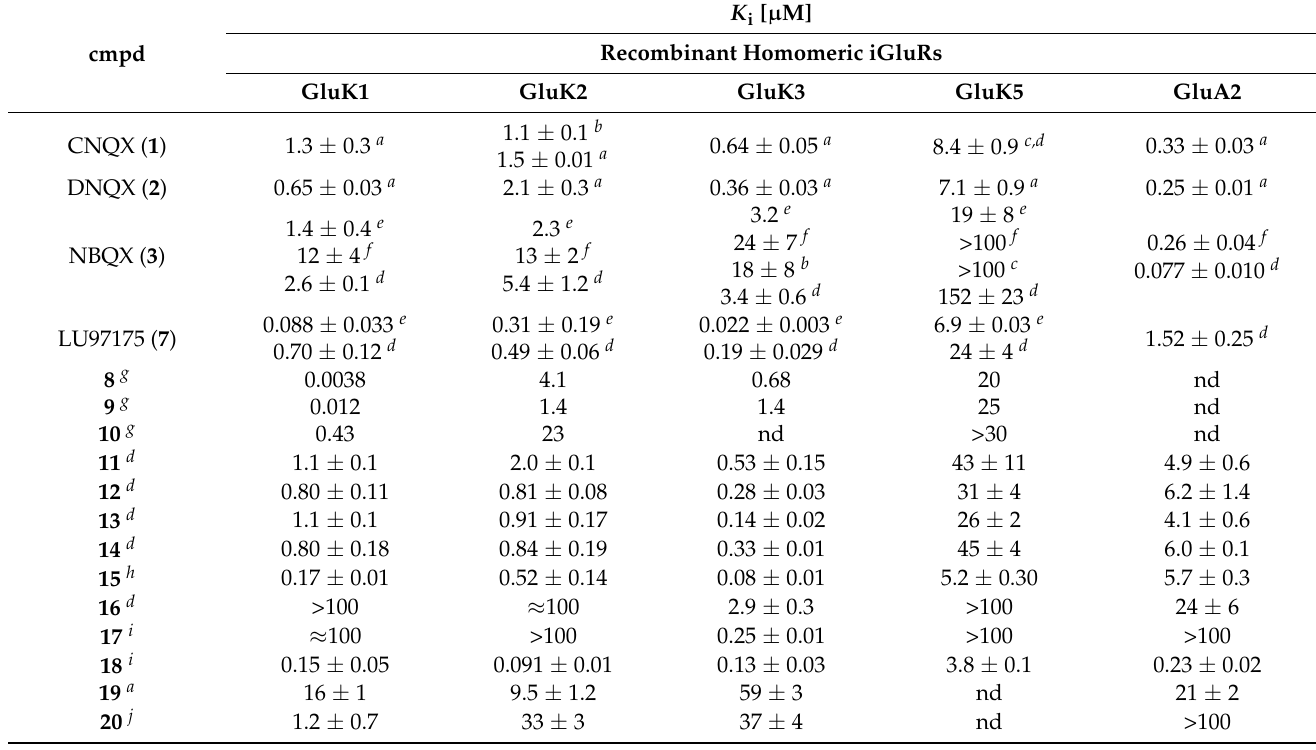
Table 2. Receptor binding affinity of selected quinoxaline-2,3-diones at recombinant homomeric iGluRs, determined in radioligand binding assays (all values in µ